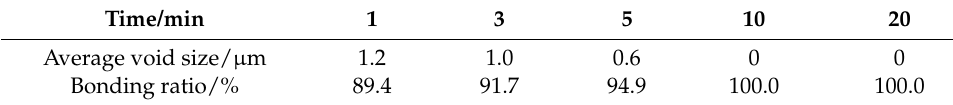
Table 1. Average void size and bonding ratios at different times.